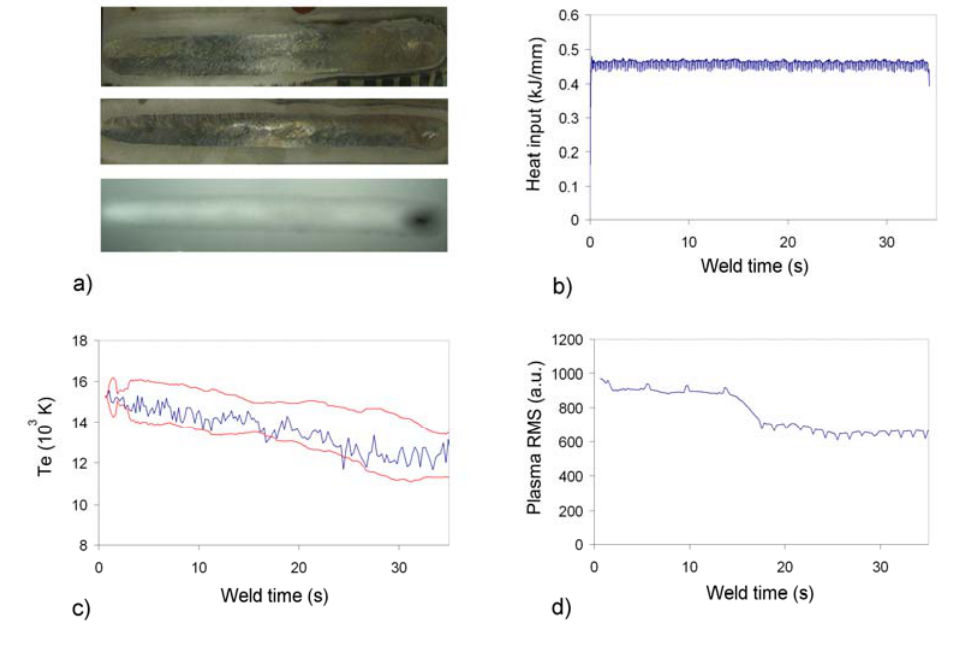
Figure 8 . Heat input, T on Titanium